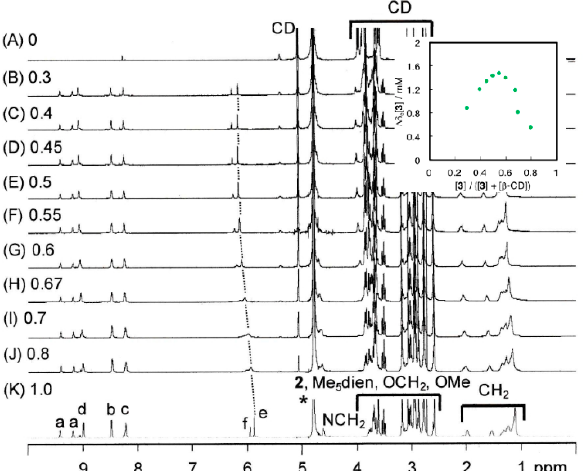
Figure 1. 1 H-nuclear magnetic resonance (NMR) spectra of the mixtures of [3] 3 + and β -cyclodextrin. (D 2 O, r.t., 500 MHz). [3] / ([3] + [ β -CD]) = ( A ) 0, ( B ) 0.3, ( C ) 0.4, ( D ) 0.45, ( E ) 0.5, ( F ) 0.55, ( G ) 0.6, ( H ) 0.67, ( I ) 0.7, ( J ) 0.8, ( K ) 1.0. Signals a-f are assigned to the hydrogens of complex 3 , in Scheme 2. A signal with asterisk is due to HDO in the solvent. Job’s plots based on the positions of the signal (e) are shown in the inset.